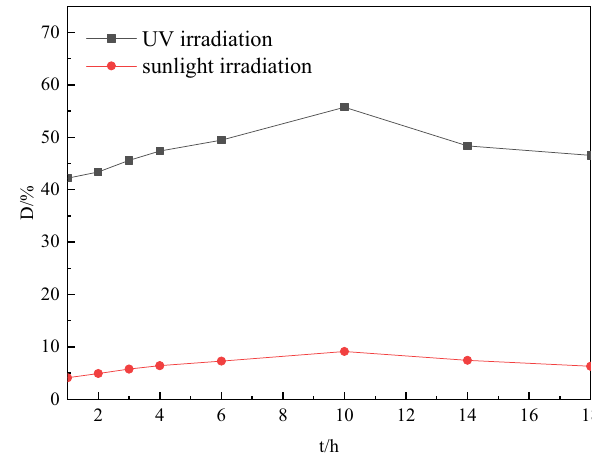
Figure 6: Photocatalytic degradation e ffi ciency of CdS/TiO 2 composite photocatalysts at di ff erent ball milling